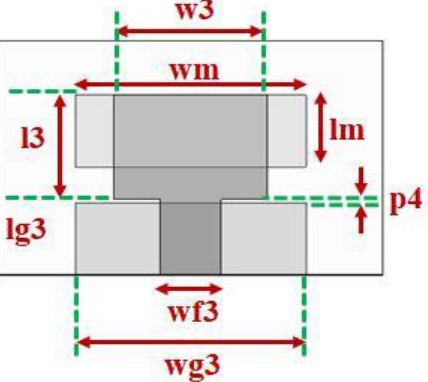
Figure 13. Schematic of the antennas linked with P18 to P24 .